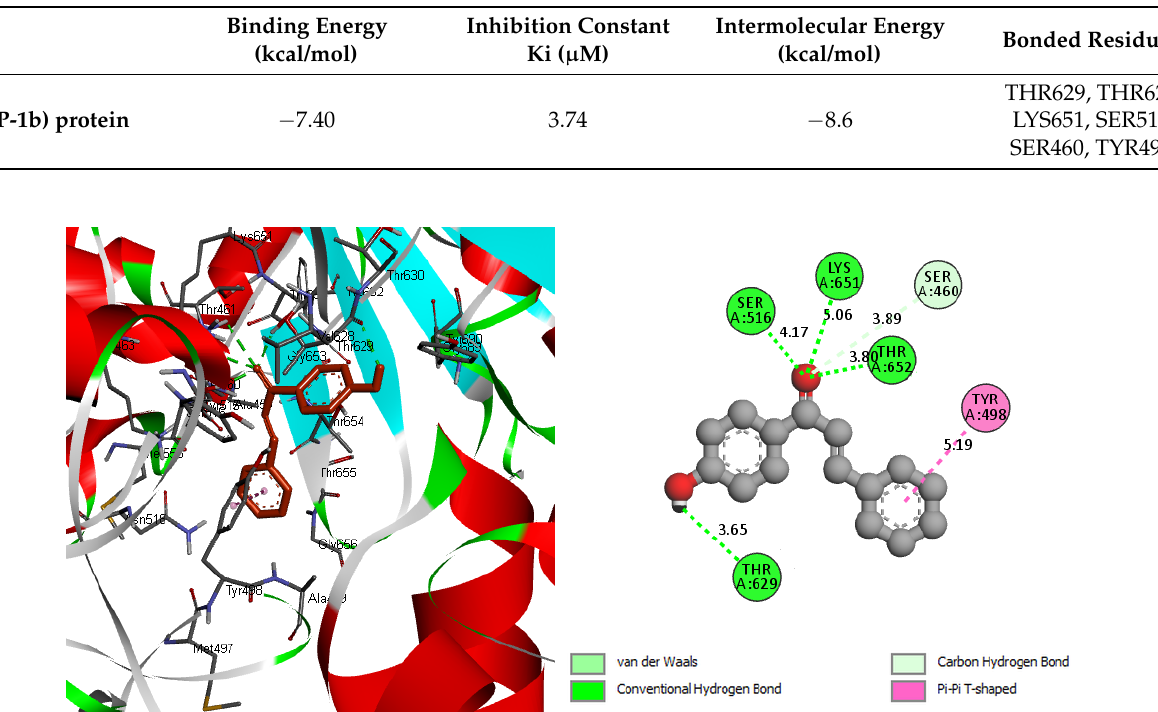
Table 4. The binding energy and interacted residues obtained from molecular docking calculations.